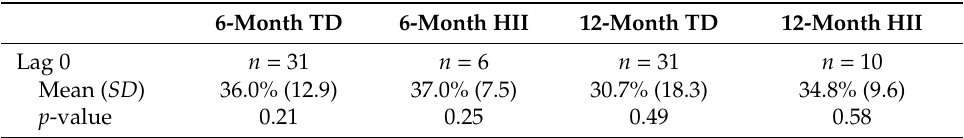
Table 3. Percentage of time on match face in TD and HII at 6 and 12 months during the full time window (0–5000 ms) for relational